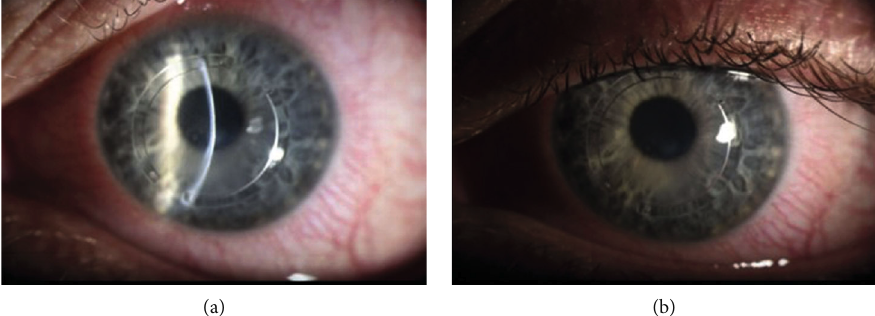
Figure 2: Slit beam (a) and broad beam (b) photographs of the left eye. These photographs demonstrate regression of the perilimbal injection and inferior hypopyon observed in Figure 1.